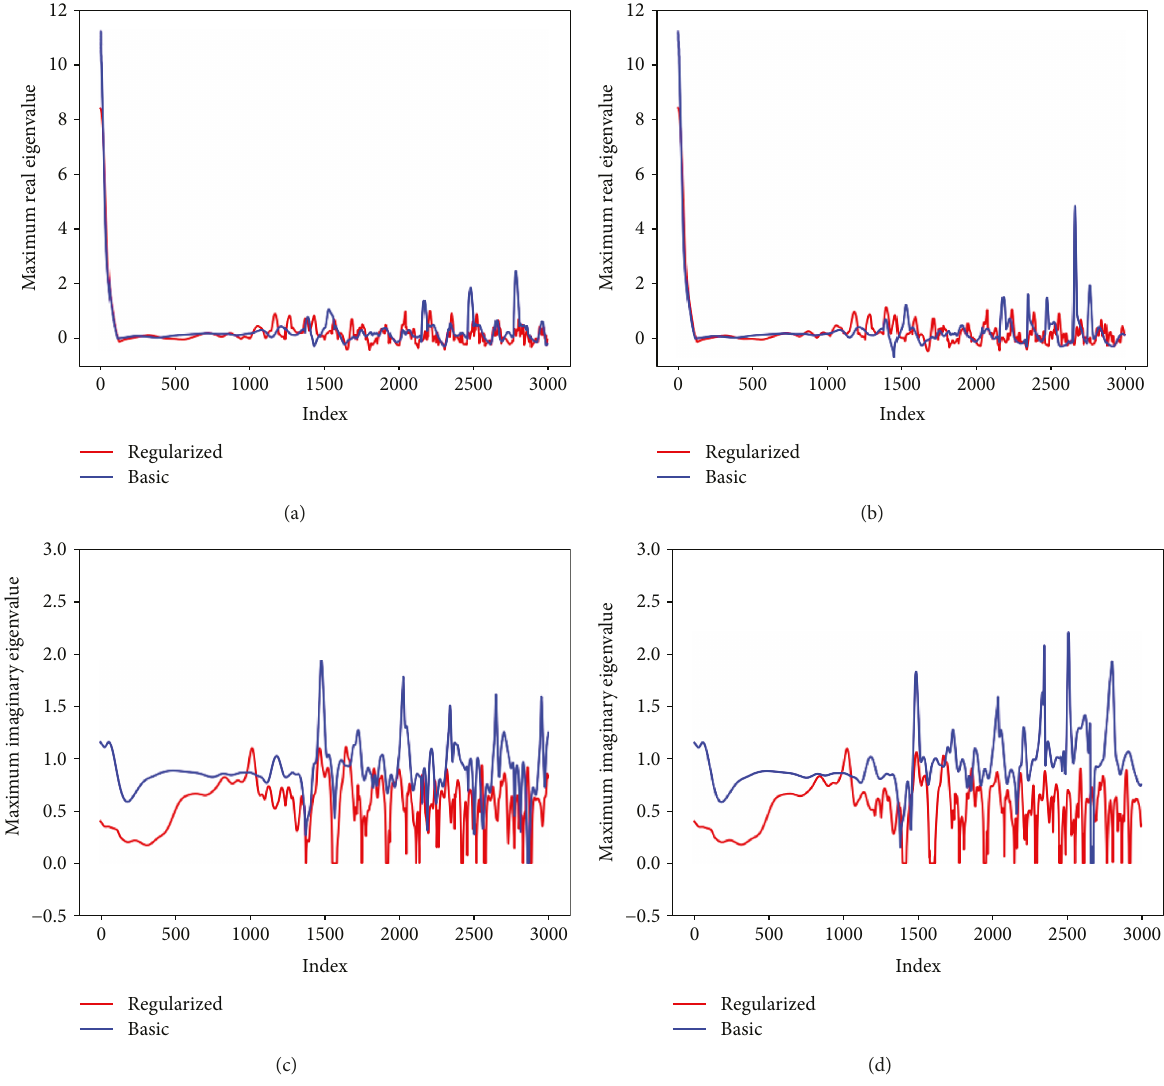
Figure 16: Flow in a cylinder wake. Comparison of eigenvalue of the Jacobian between regularized and basic model on training data. (a, b) Maximal real eigenvalue. (c, d) Maximal imaginary eigenvalue. (a, c) A priori. (b, d) A